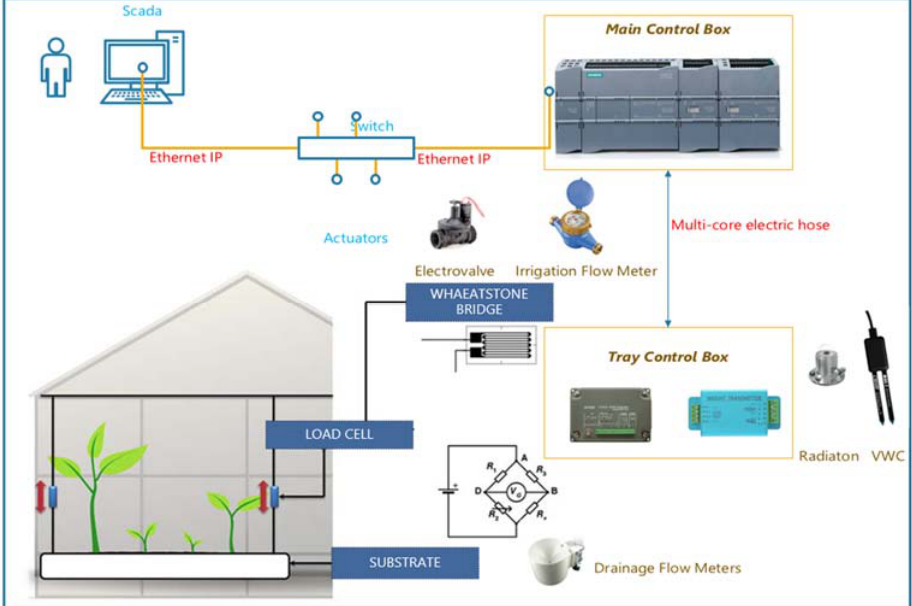
Figure 2. General view of the test facility control architecture to manage three different irrigation methods, Gravimetry (G); Volumetric Water Content (VWC); Accumulated solar radiation (AR).